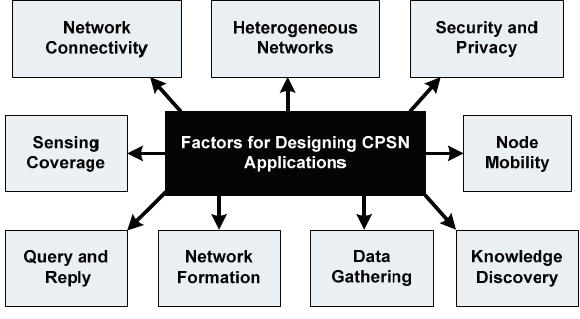
Figure 13. Relevant factors for designing CPSN